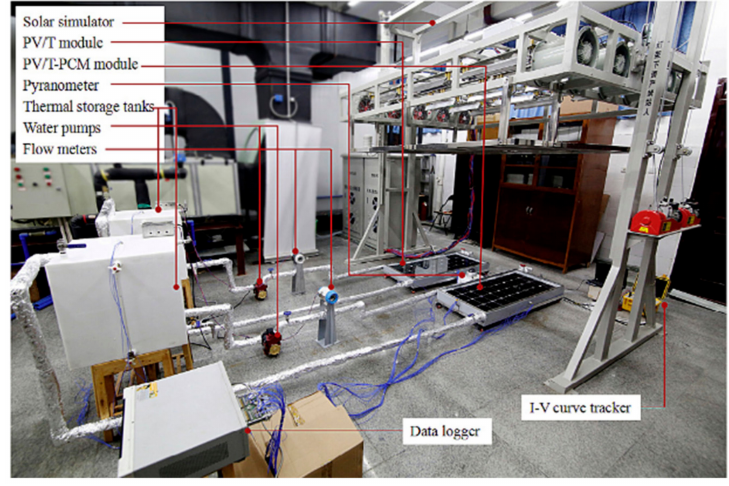
Figure 2. PV / T-PCM system setup.